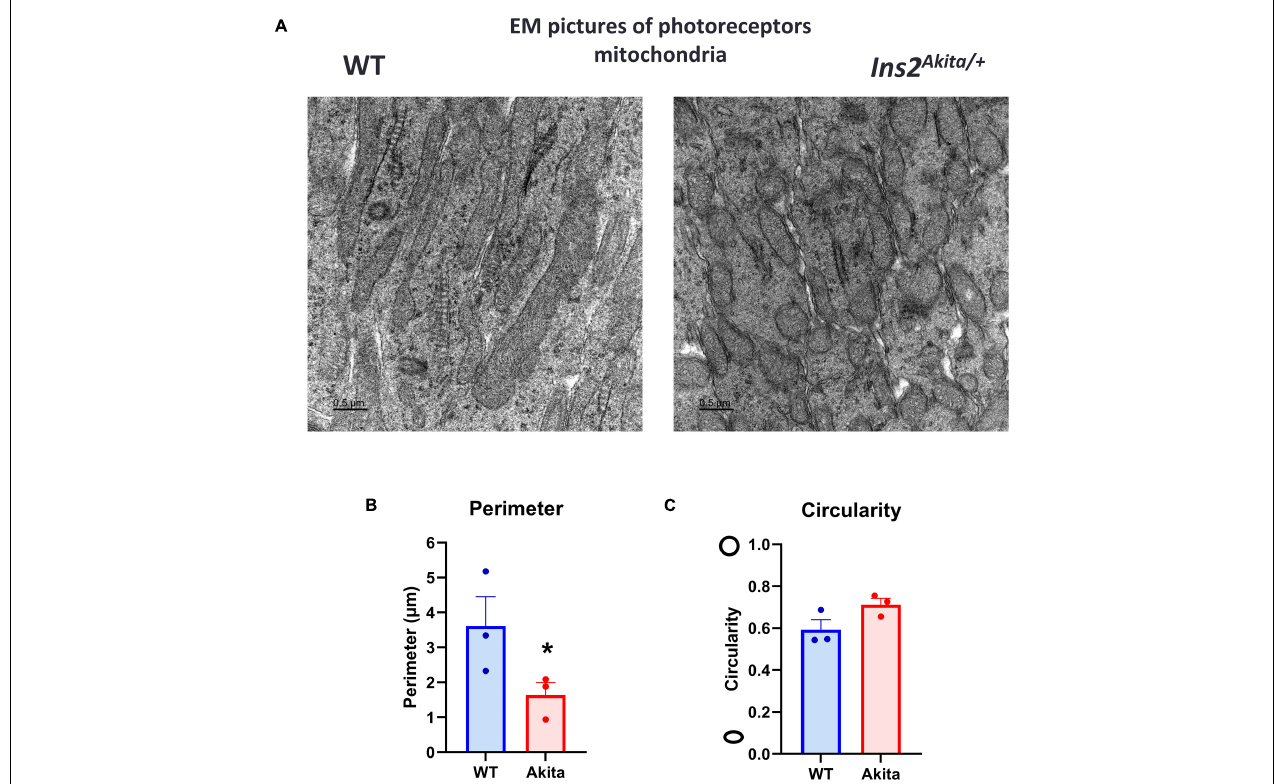
FIGURE 4 | Electron microscopic examination of retinal mitochondrial morphology in diabetes. (A–C) Electron microscopic examination of mitochondria in the photoreceptor inner segment layer shows a fragmented morphology in 5-month-old Ins2 Akita diabetic retina as evident by decrease in mitochondria perimeter and increase in circularity yet the later did not reach statistical significance. N = 3, * p < 0.05 vs.